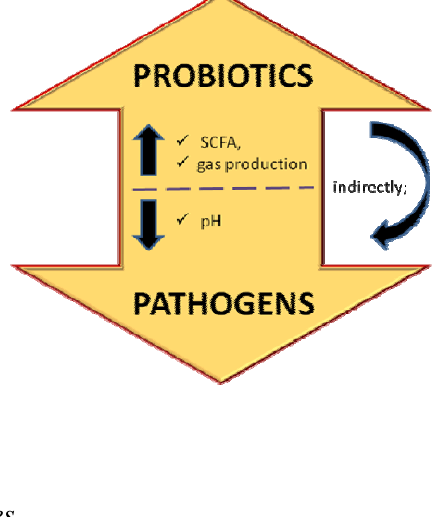
Figure 4. Prebiotics mechanism in manipulating intestinal